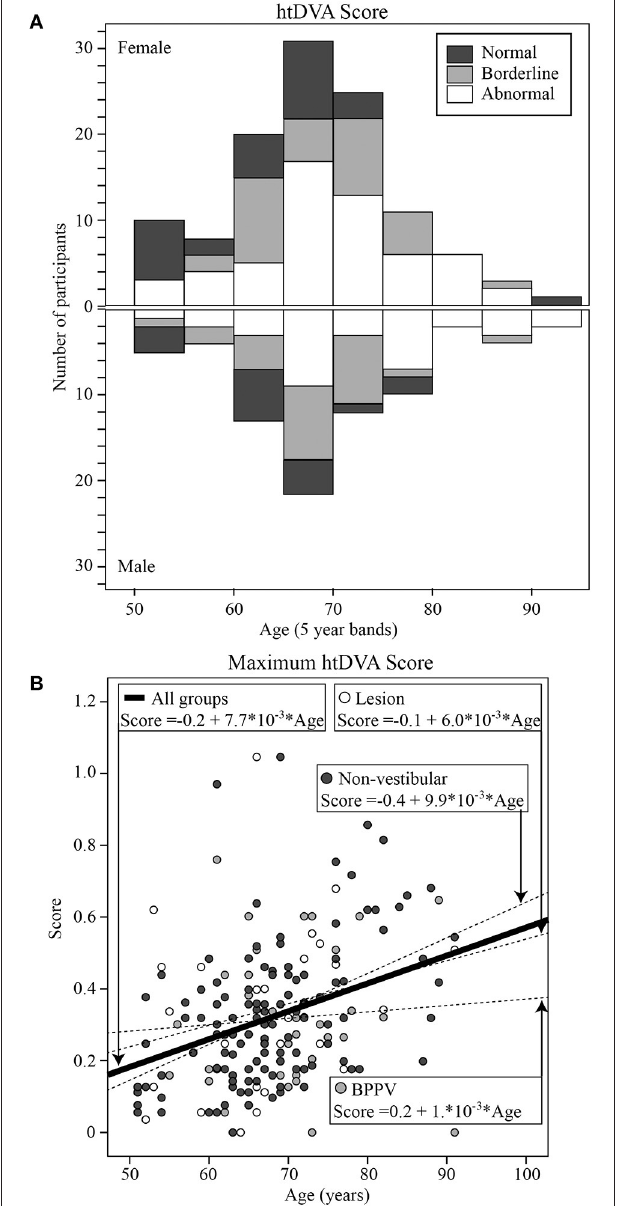
FIGURE 3 | (A) Histogram of htDVA scores binned as normal, borderline, and abnormal vs. age (with 5-years bands). (B) Maximum htDVA score [across all canal planes [left anterior, left posterior, left horizontal, right anterior, right posterior, right horizontal]] calculated for each participant vs. their age, clustered by group with group and overall line-fits.